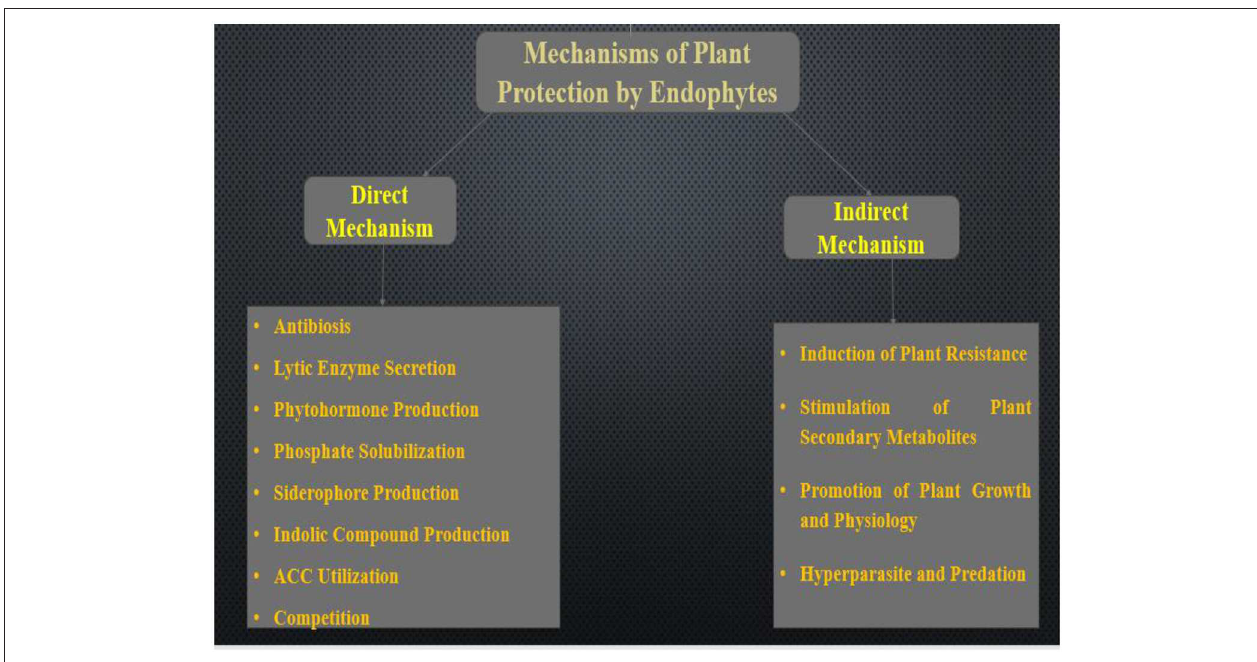
FIGURE 1 | Mechanisms employed by endophytes for plant